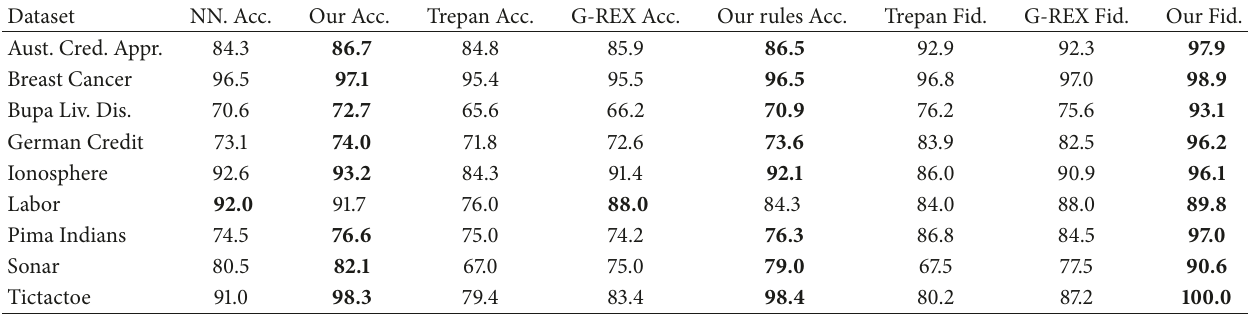
Table 12: Comparison on neural network ensembles with respect to Trepan [13] and G-REX [14]. Our results in the last three columns are those provided by DIMLP-B.